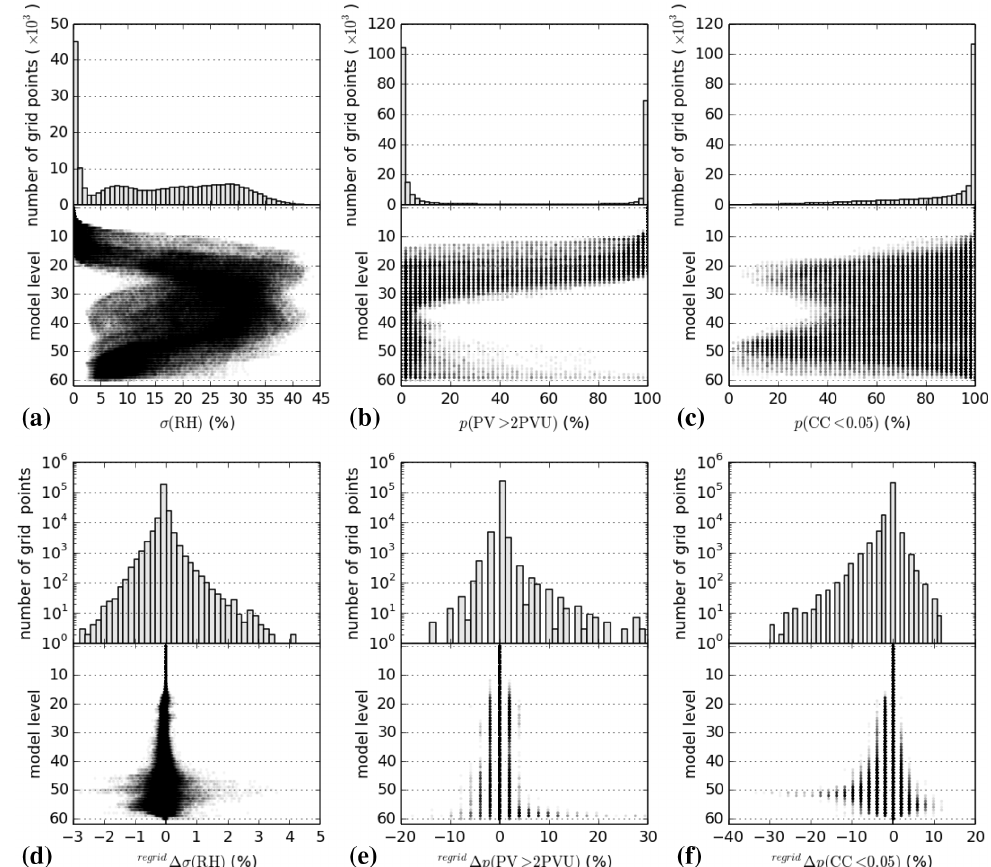
Figure 16. The same as Fig. 15 but for variables depending on moisture; ( a and d ) SD of relative humidity; ( b and e ) probability of potential vorticity exceeding 2 PVU; ( c and f ) Probability of grid box cloud cover fraction falling below 0.05.